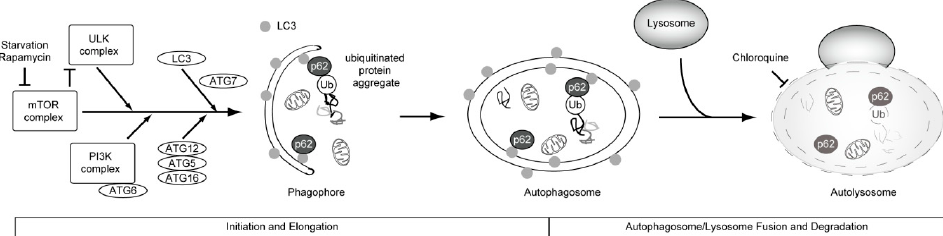
Figure 2. Overview of autophagy. Nutrient depletion and stress signaling, trigger autophagosome formation upon mTOR (mammalian target of rapamycin) inhibition (Initiation and Elongation).